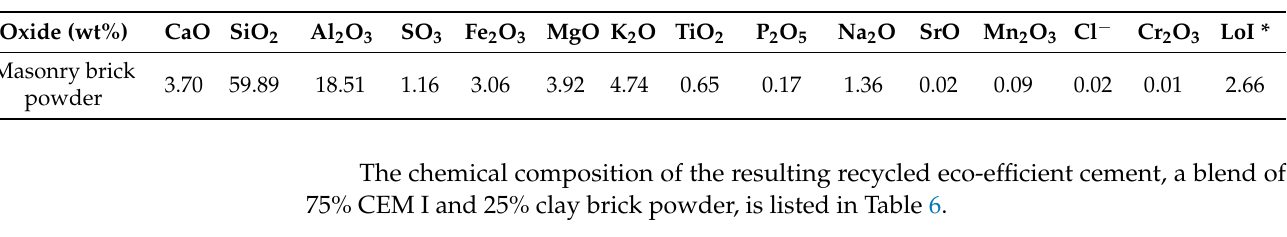
Table 5. Chemical composition of the masonry brick powder used in eco-efficient cement manufacture [31,32].